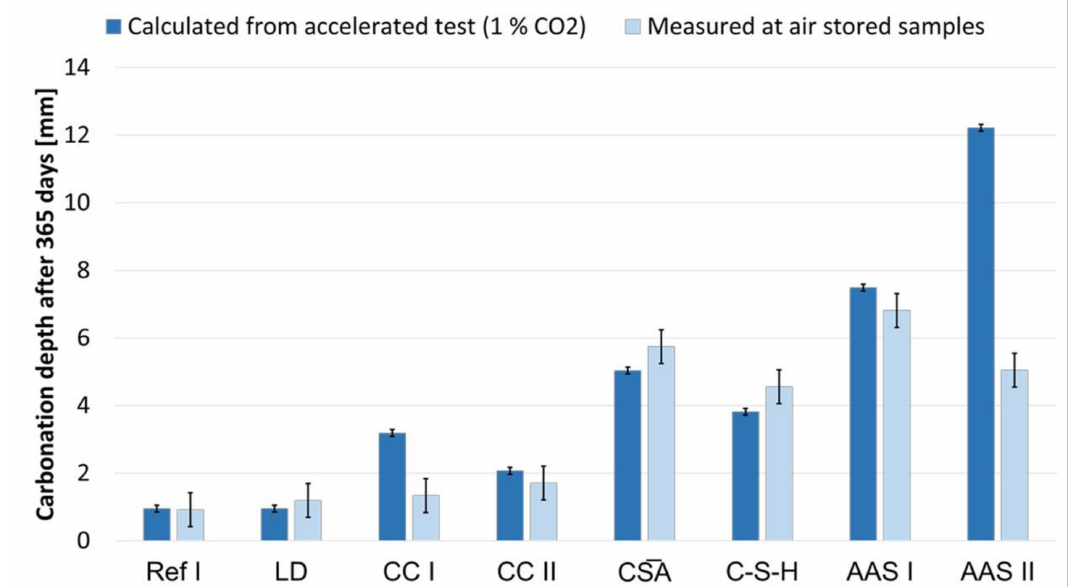
Figure 9. Comparison of calculated carbonation depths from accelerated test and measured values from air